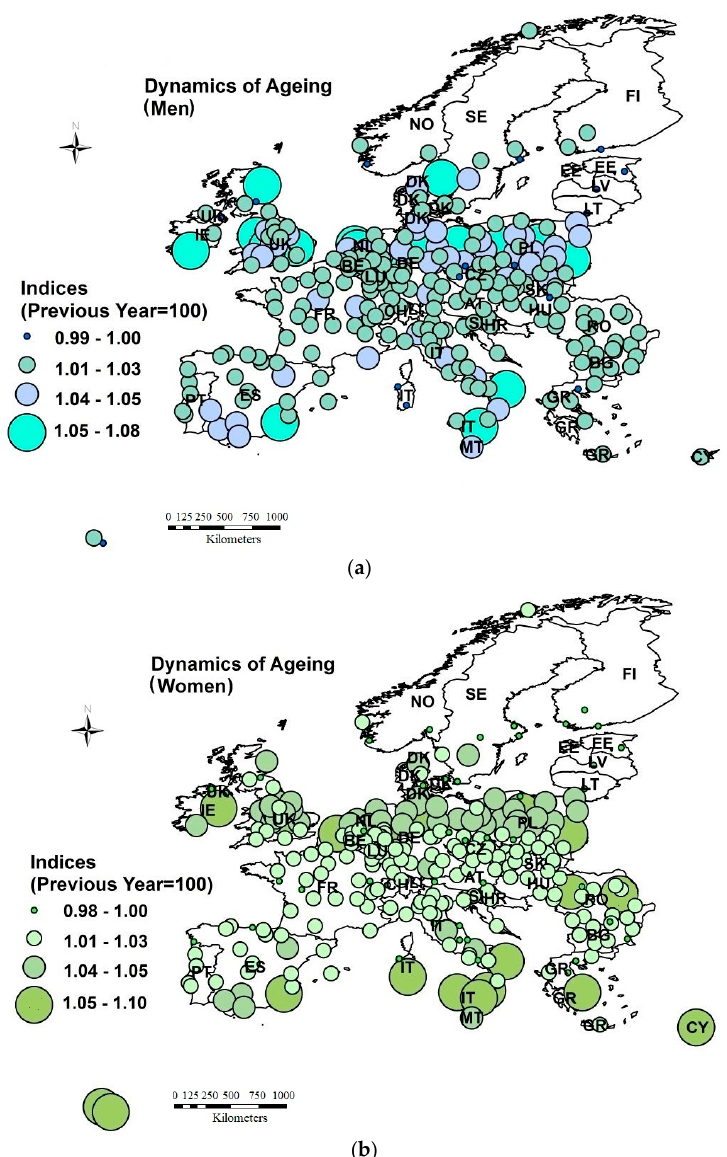
Figure 2. Dynamics of the men ( a ) and women ( b ) ageing process in European cities in the years 1990–2018 (annual averaged indices). Source: Own elaboration in ArcGIS (ArcMap 10.5).